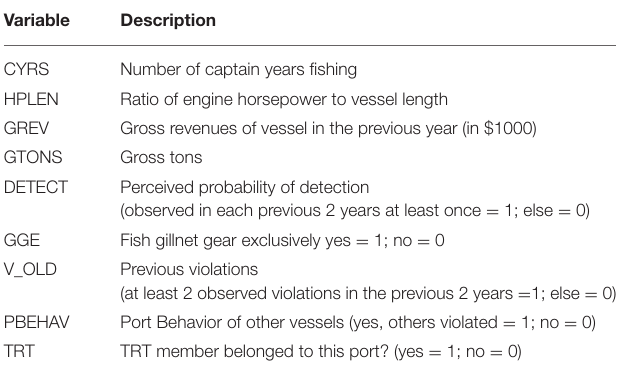
TABLE 1 | Description of independent